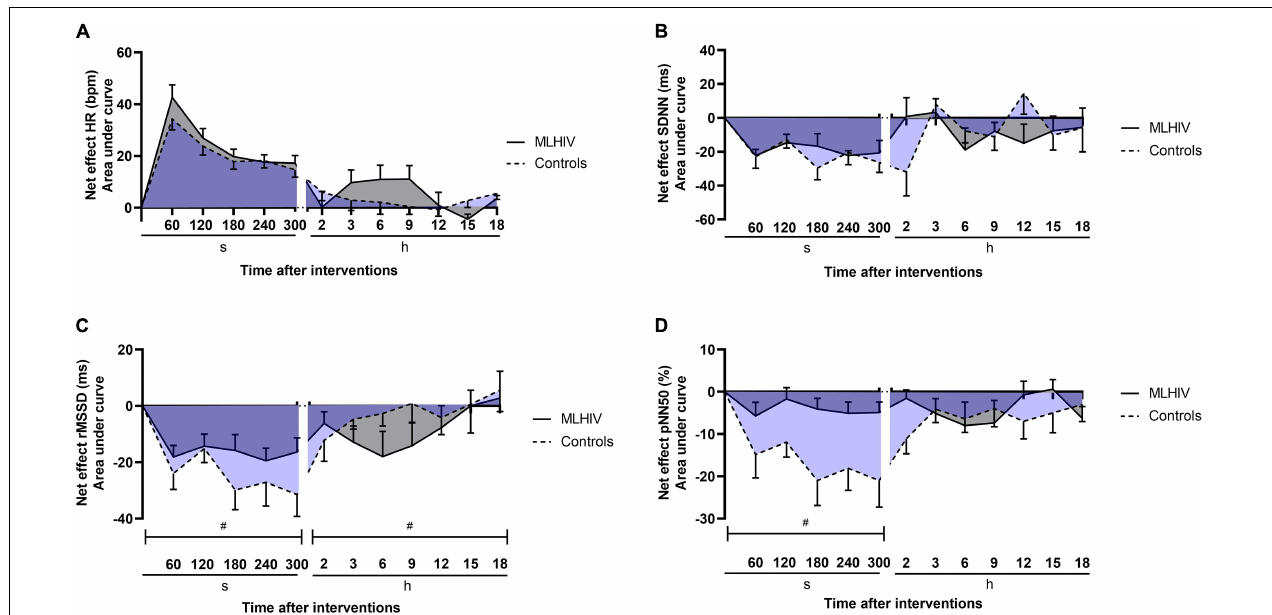
FIGURE 6 | Exercise net effects on heart rate (A) and heart rate variability indices (B–D) in controls and men living with HIV (MLHIV). SDNN, standard deviation of normal to normal intervals; rMSSD, root mean square of successive differences between normal intervals; pNN50, percentage of differences between adjacent normal intervals. # p < 0.05 for differences between areas under the curves of controls vs.